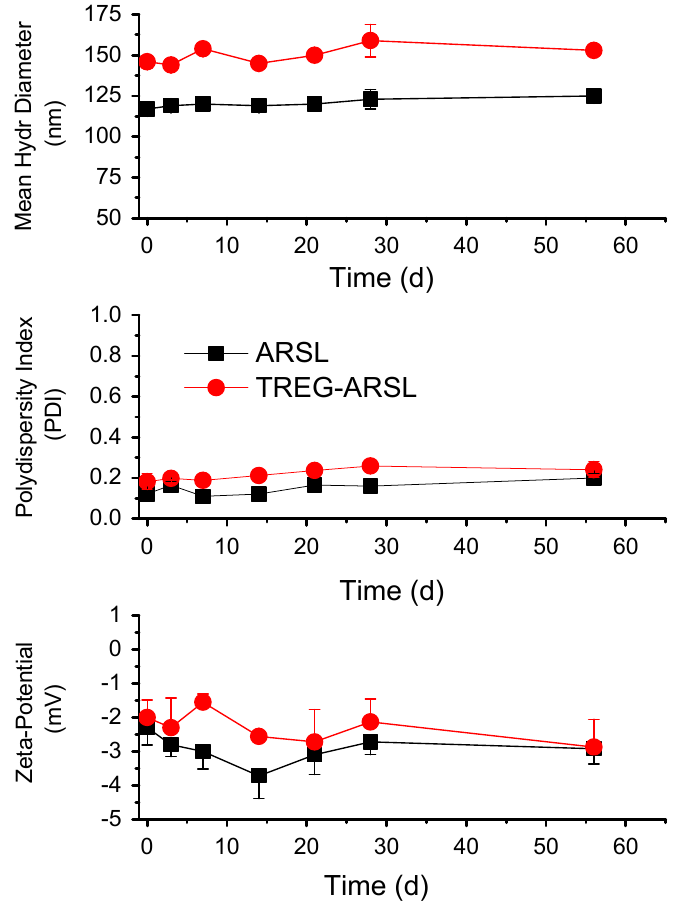
Figure 2. Physical stability of ARSL and TREG ‐ ARSL for a period of 56 days at 4 °C.